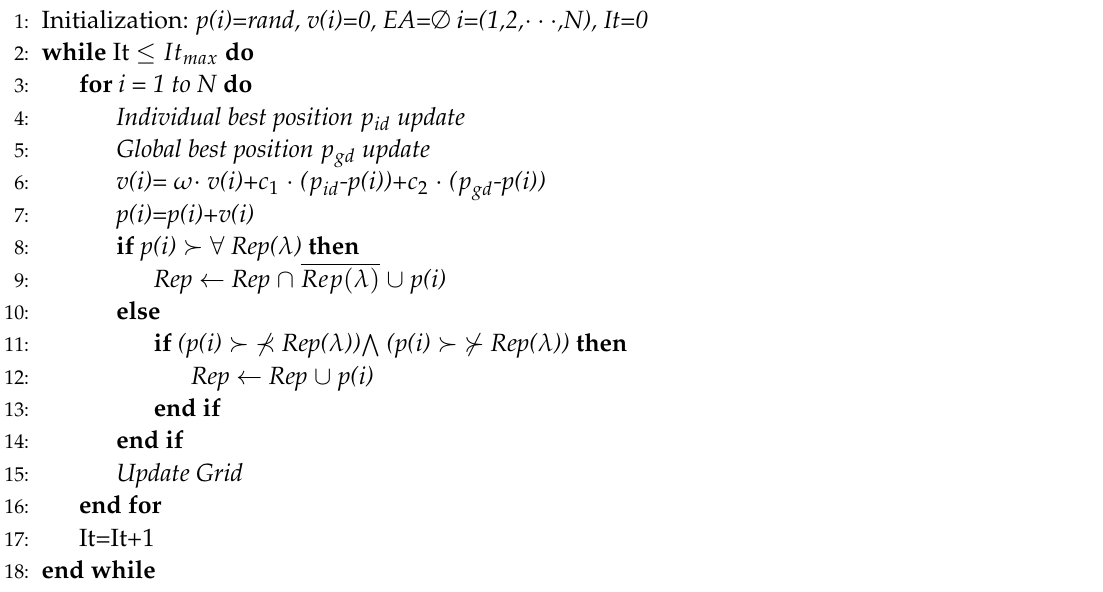
Algorithm 1 MOPSO